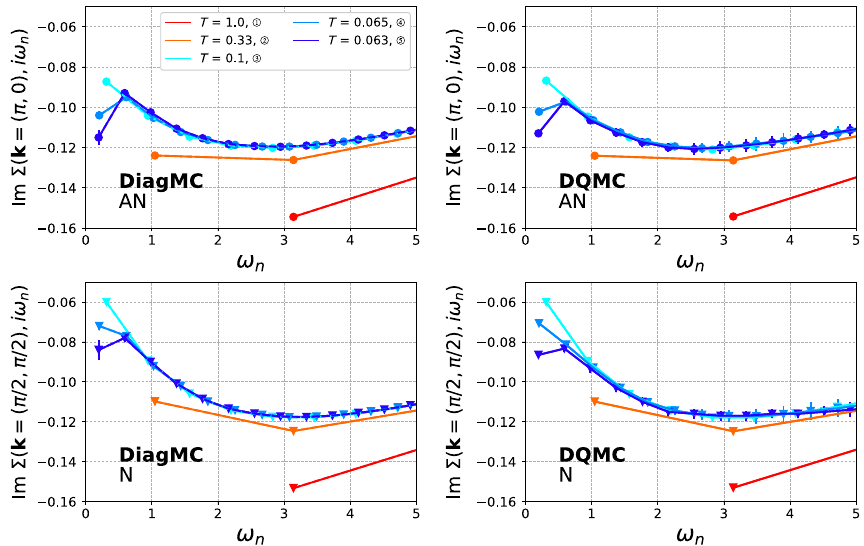
FIG. 3. Imaginary part of the self-energy for the antinode (upper row) and node (lower row) as a function of Matsubara frequencies for the two numerically exact techniques, DiagMC (left panels) and DQMC (right panels). Note that the error bars may be of the order of the marker